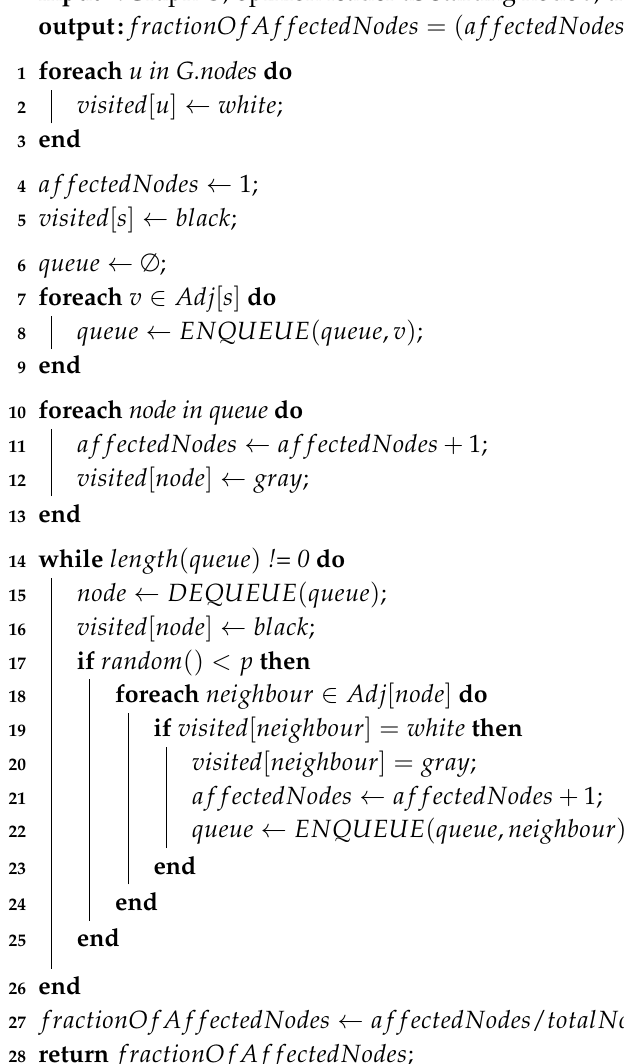
Algorithm 1: Simple diffusion process (Adapted from